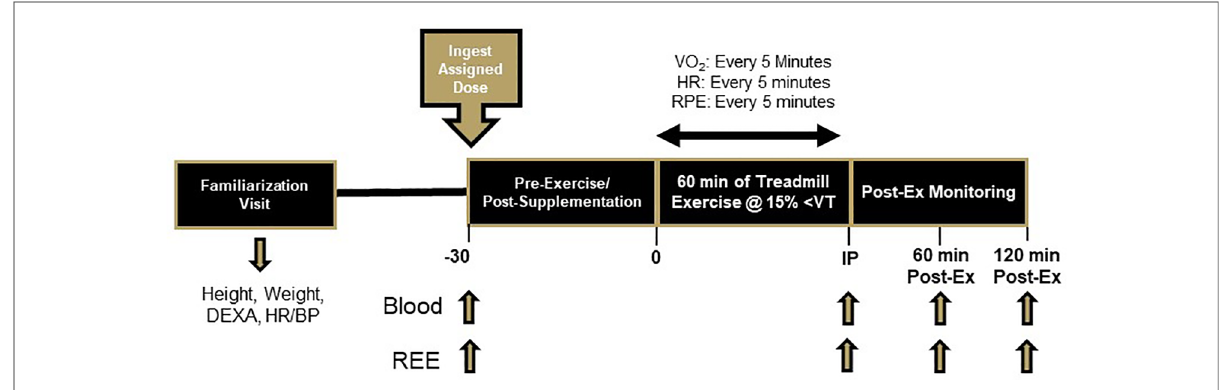
FIGURE 1 Overview of research